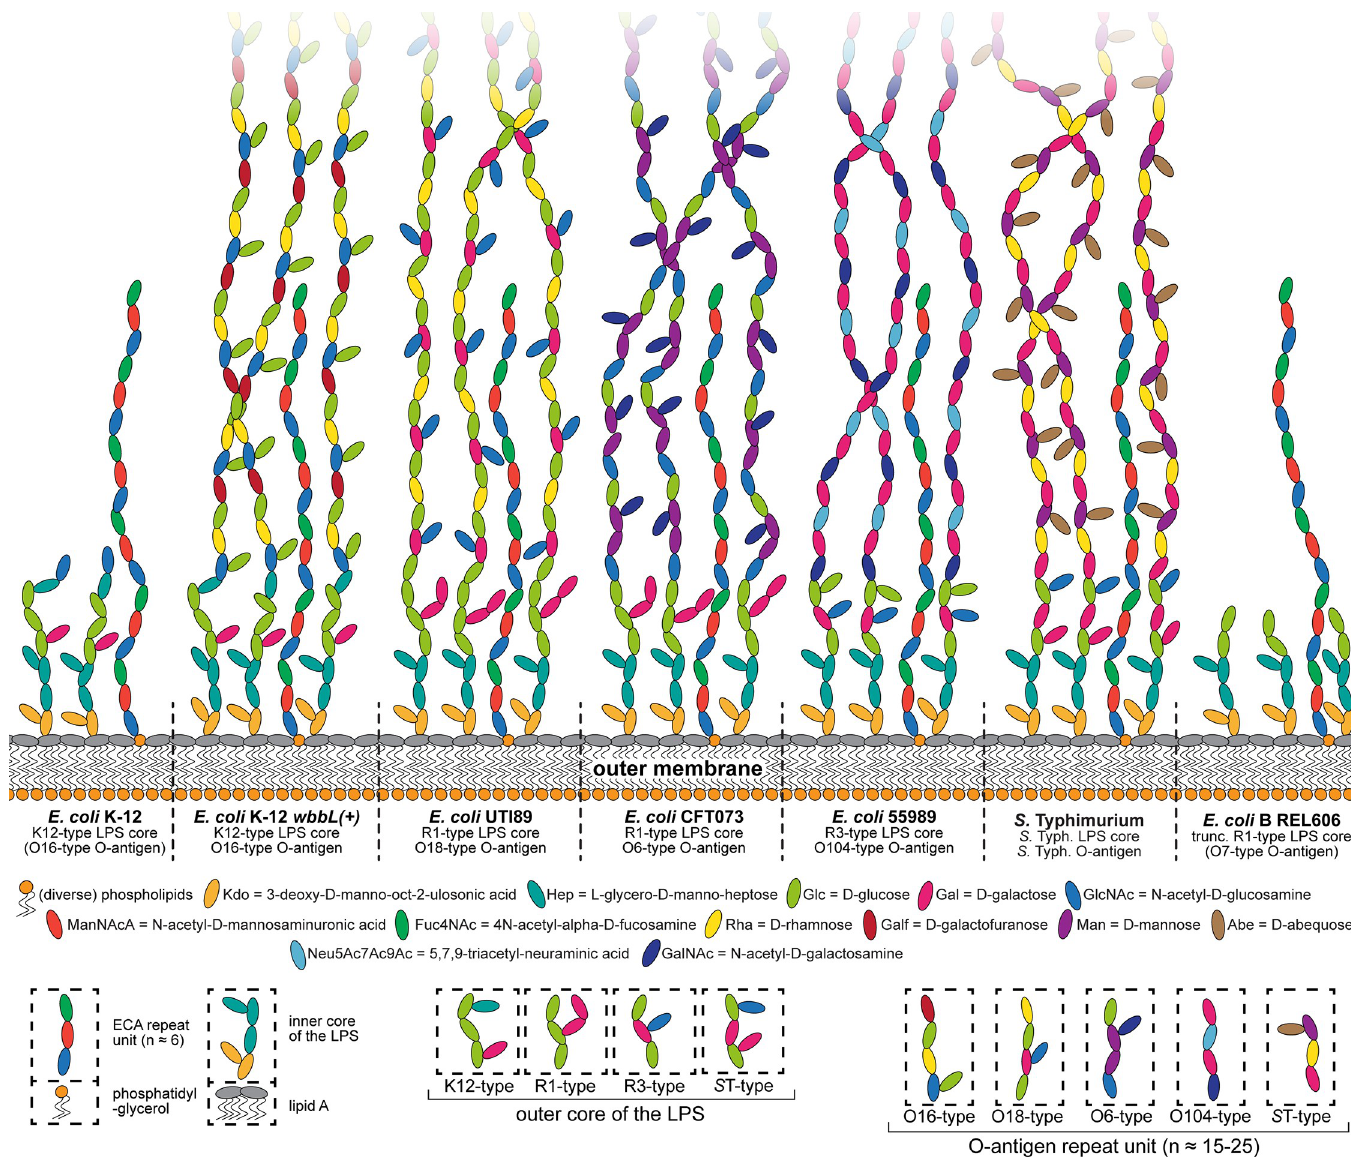
Fig 11. Surface glycans of the enterobacterial strains used in this work. The known surface glycans of different enterobacterial strains used in this work were drawn in comparison to highlight the diversity and barrier function of their O-antigen as well as the slight differences between LPS core types (see Materials and methods for details on how the illustration was composed). ECA, enterobacterial common antigen; LPS,